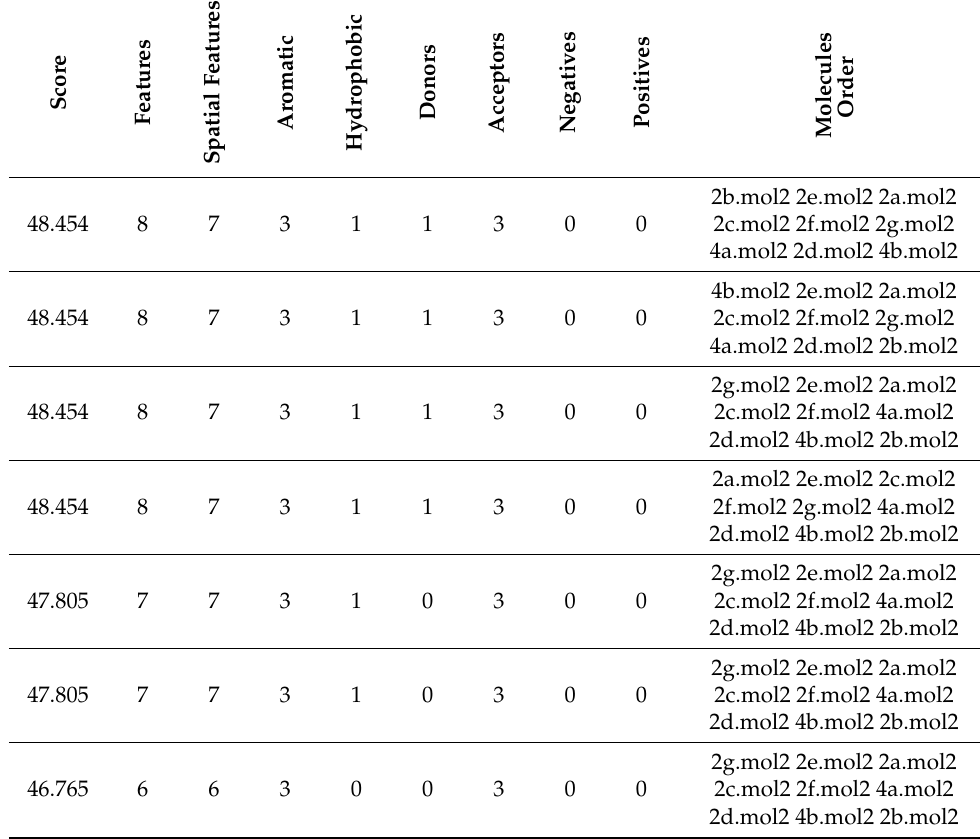
Table 4. Putative Pharmacophore Groups Outcomes, for